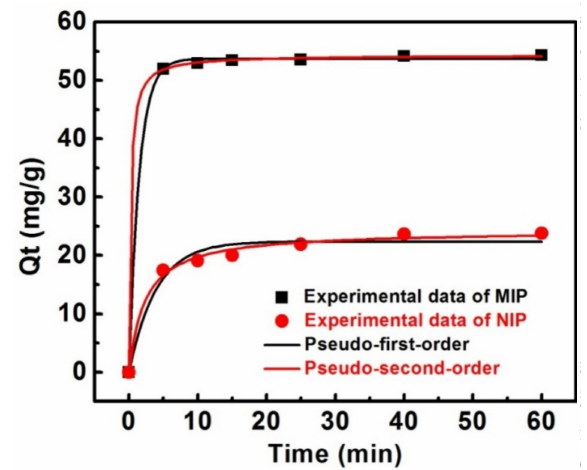
Figure 5. Adsorption kinetics of gossypol binding onto MIPs and NIPs prepared using spherical silica